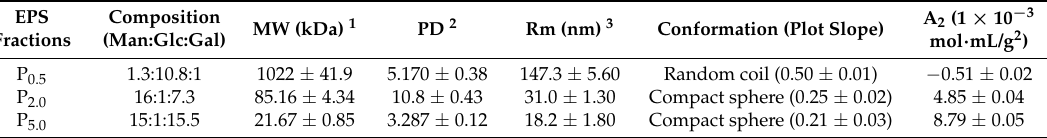
Table 1. Composition and properties of EPS